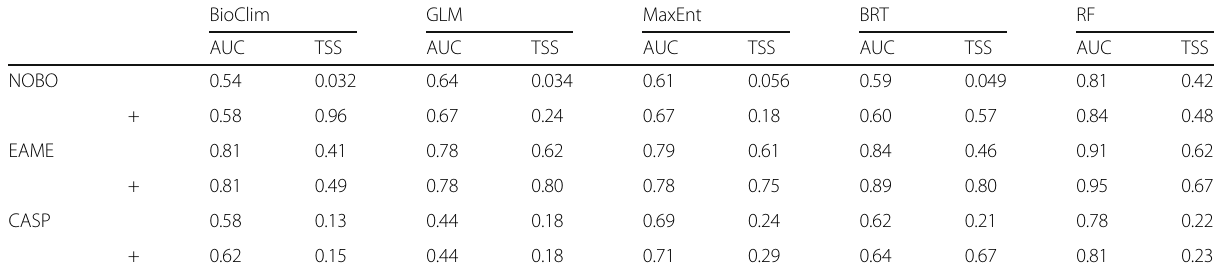
Table 3 Results of species distribution model (SDM) performance for Bioclim, generalized linear model (GLM), MaxEnt, boosted regression tree (BRT), and random forest (RF) algorithms in predicting occurrence of Northern Bobwhite (NOBO), Eastern Meadowlark (EAME), and Cassin ’ s Sparrow (CASP) on East Foundation ’ s Coloraditas Grazing Research and Demonstration Area (CGRDA) in the summer of 2016. Model performance metrics (area under curve [AUC] and true sensitivity statistic [TSS]) are compared for SDMs using environmental predictors only, and environmental predictors stacked with a raster representing localized grazing pressure (denoted by “ + ” ).